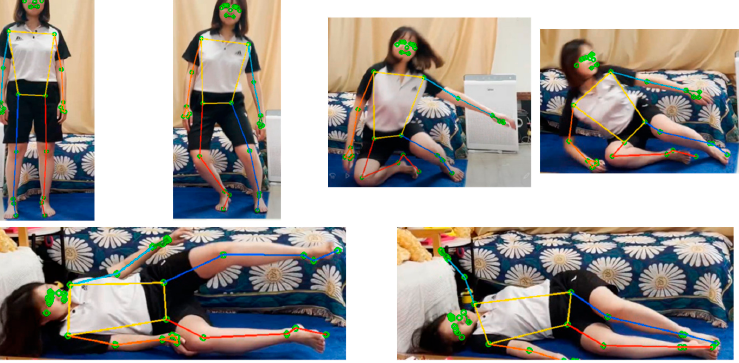
the proposed approach.